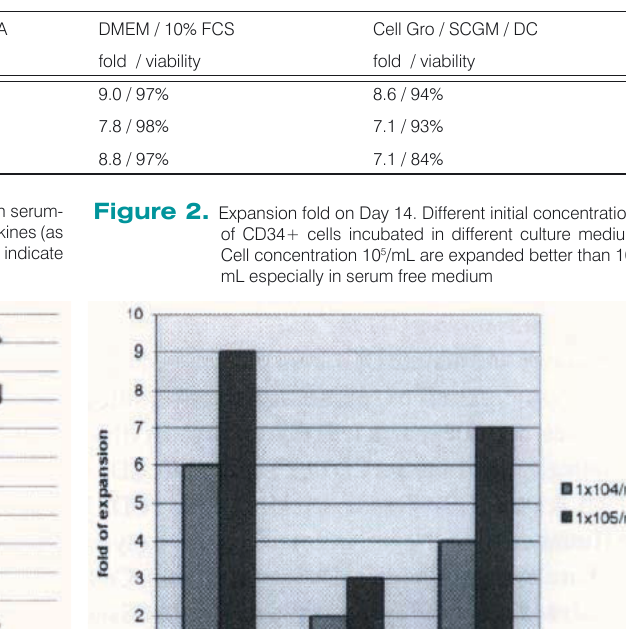
Table 1. Expansion fold and viability on Day 14.